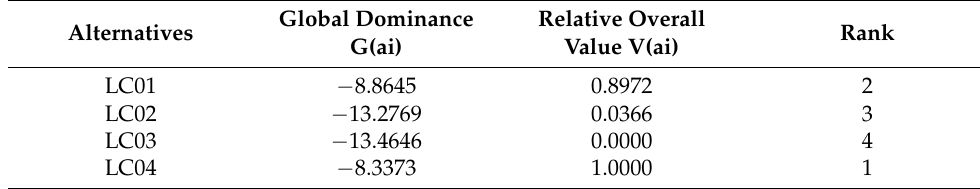
Table 5. Final ranking from TODIM model.